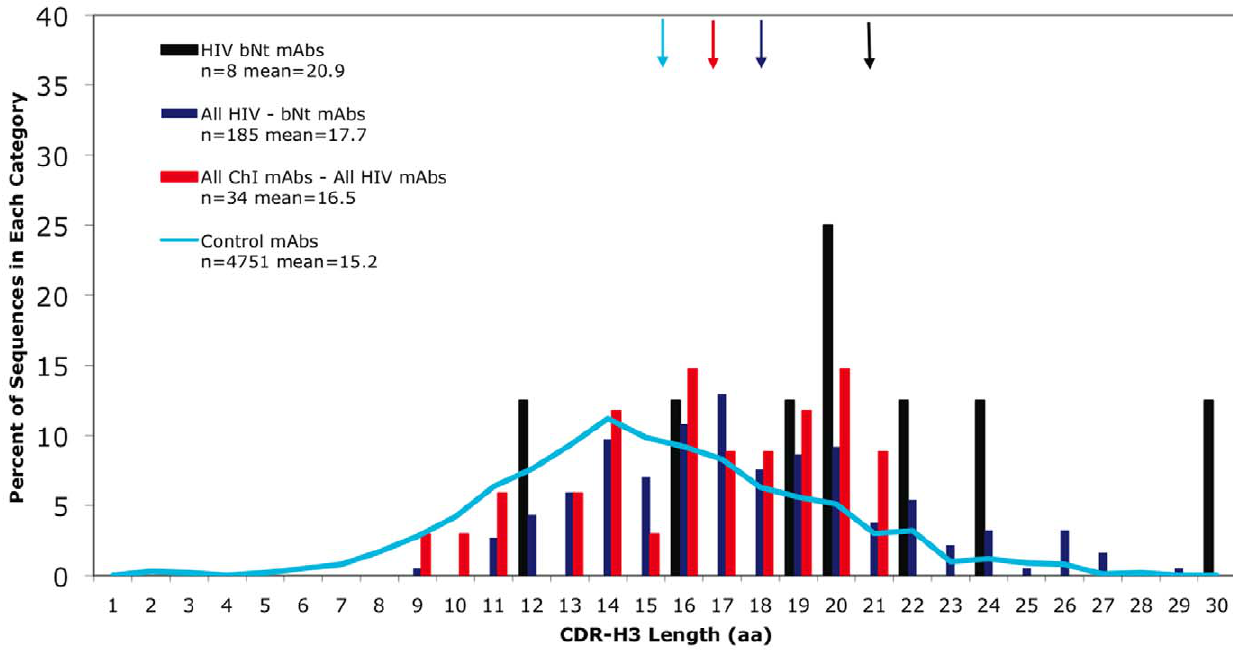
Figure 1. Distribution of CDR-H3 length for HIV Mabs. HIV Mabs are divided into three categories: bNt HIV MAbs, all HIV MAbs with the bNt HIV MAbs removed ( i.e., non-bNt HIV MAbs), and ChI MAbs with the HIV MAbs removed ( i.e ., non-HIV ChI MAbs). Arrows indicate the mean for each category. Distribution of CDR-H3 length for more than 4000 Abs compiled from IMGT and Kabat databases [63] is included in Figs. 1–3, as a control comparison (blue line). The average CDR-H3 length of the 425 Ag-specific MAbs was 16.3 aa, which is higher than the 15.2-aa mean reported for 4751 expressed V H sequences compiled from the Kabat and IMGT databases by Zemlin et al. [63]; this may reflect that our data set included a higher proportion of ChI Abs, both HIV and non-HIV.